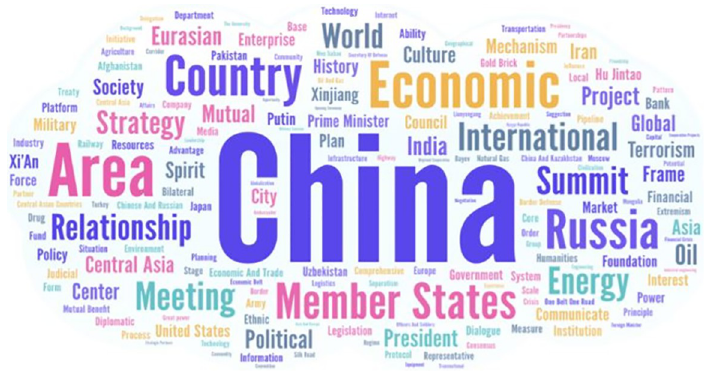
Fig 4. The word cloud graph of all key